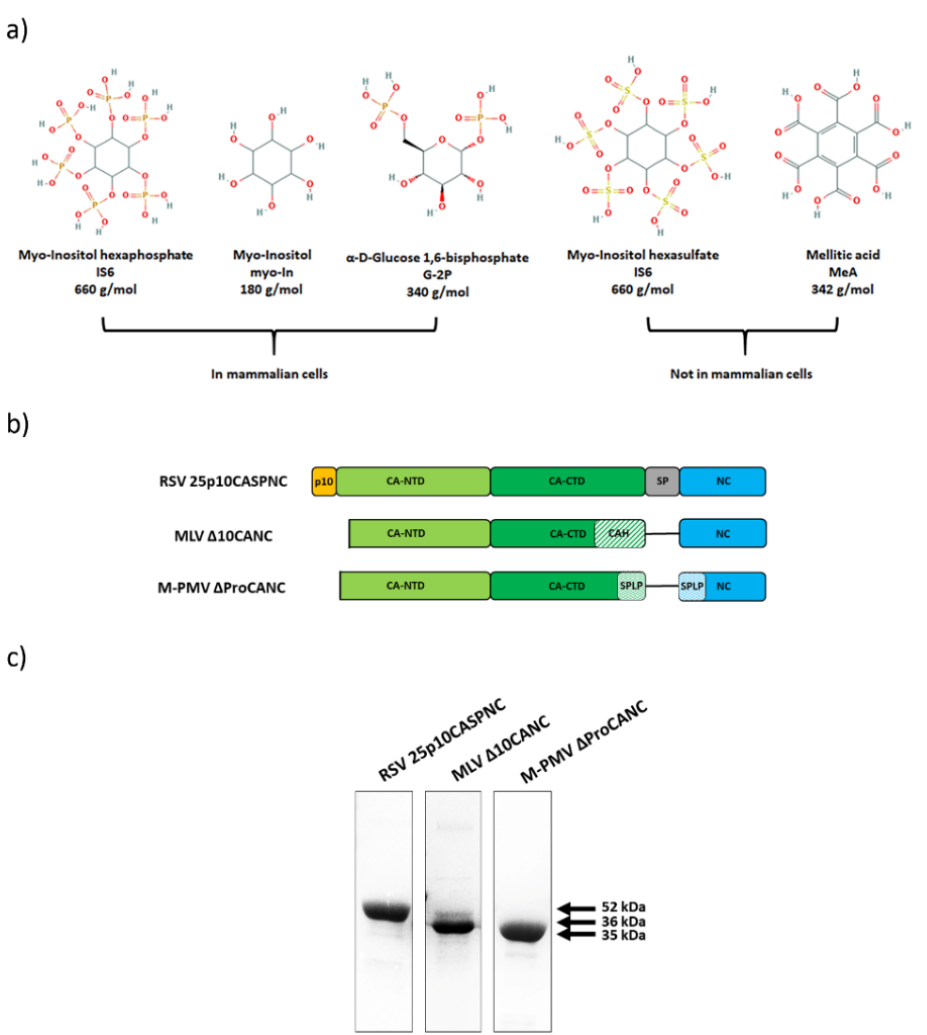
Figure 1. Gag-derived CANC proteins of Rous sarcoma virus (RSV), murine leukemia virus (MLV) and Mason-Pfizer monkey virus (M-PMV) used in this study. ( a ) Chemical structures of the used polyanions: myo-inostol hexaphosphate (IP6), myo-inositol (myo-In), glucose-1,6-bisphosphate (G-2P), myo-inositol hexasulphate (IS6) and mellitic acid (MeA). ( b ) Schematic representation of CANC proteins of RSV, MLV and M-PMV. ( c ) Coomassie blue-stained SDS-PAGE gel, documenting the purity of the proteins.